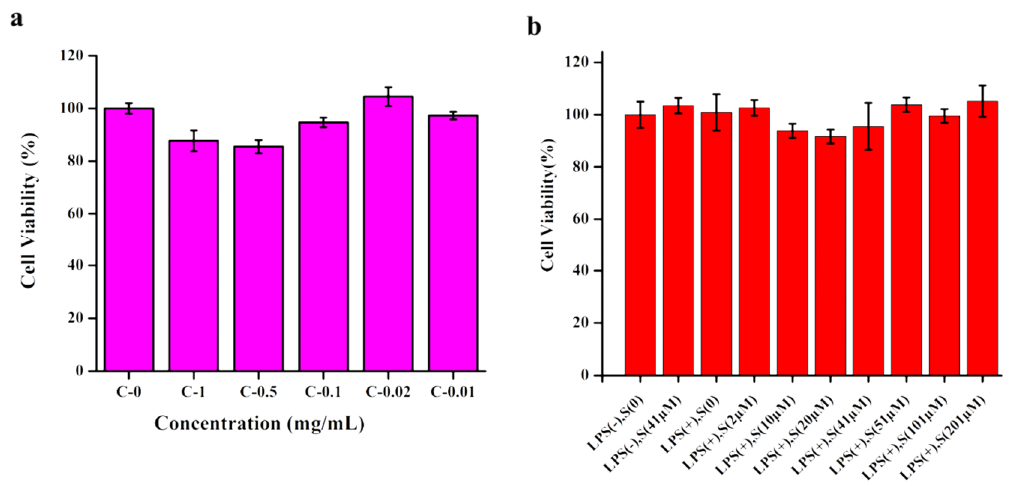
Figure 5. Viability of ( a ) HaCaT treated with Hep-PNIPAM and ( b ) LPS-induced RAW264.7 cells treated with IB-Hep-PNIPAM. “S” stands for sample of IB-Hep-PNIPAM added into cells.